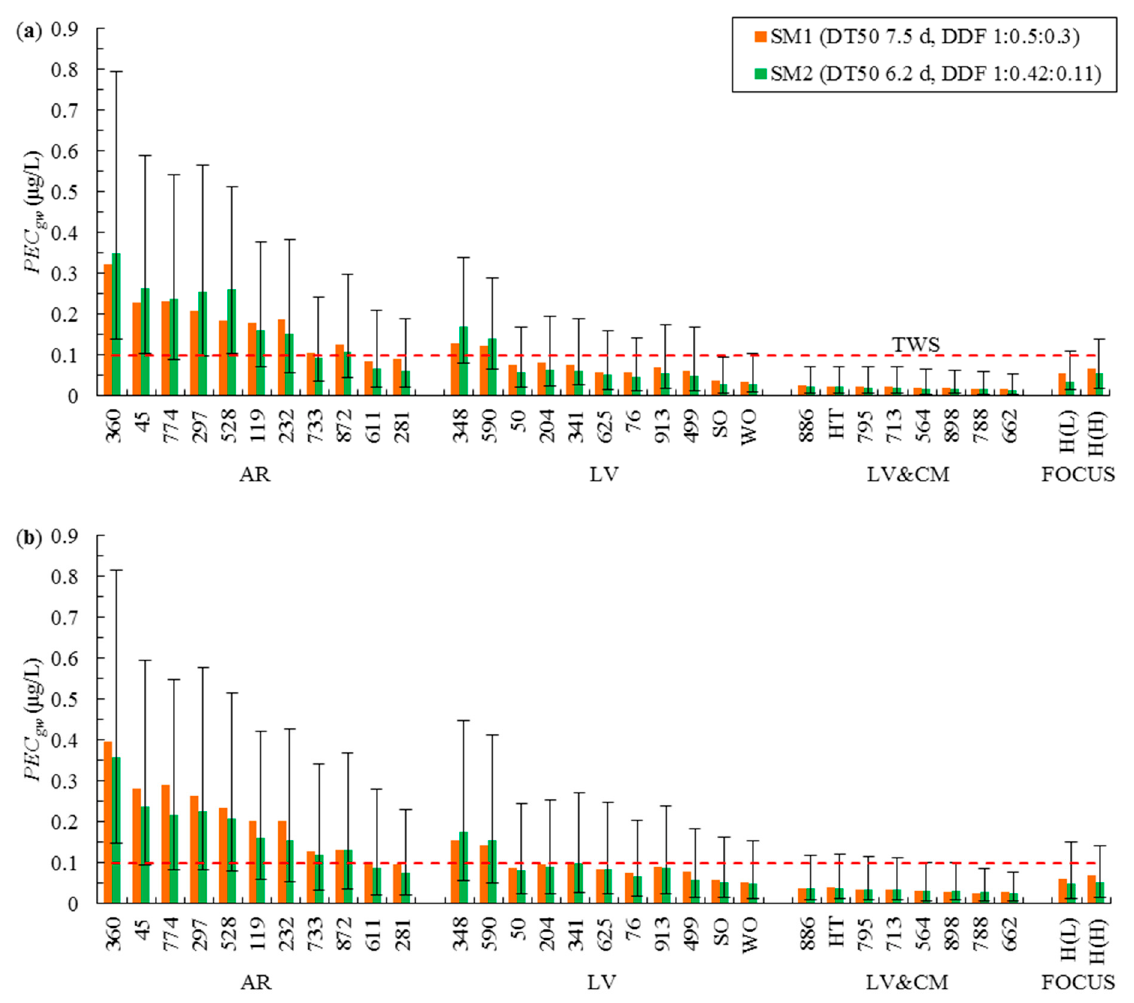
Figure 1. Values of PEC gw predicted during the simulations of: ( a ) Potato cultivation; ( b ) Maize cultivation. For SM2, the top and bottom of the error bars denote simulations involving DT50 7.5 d and 5.1 d, respectively, and DDF 1:0.42:0.11. H(L)—data for Hamburg profile and Lublin climate, H(H)—data for Hamburg profile and